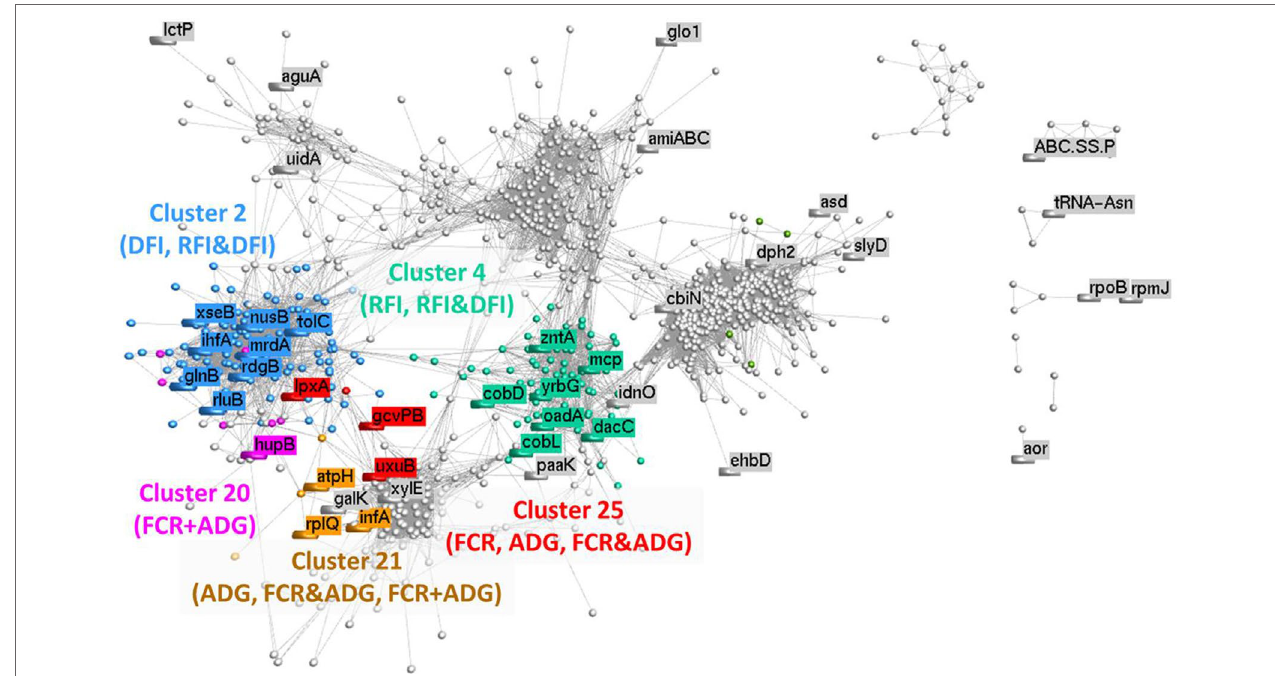
FIGURE 5 | Correlation network analysis of metagenomic data: Each node represents a vector of relative abundances of each microbial gene in all 42 animals, and the edges represent a correlation between the microbial genes. A minimum correlation threshold of 0.80 was applied to the network. Different colors illustrate different clusters, which were calculated using MCL method (inflation: 2; preinflation: 2; scheme: 6). Clusters identified by numbers were found to be significantly ( P < 0.05) enriched for microbial genes identified for the traits whose abbreviations are between brackets (FCR, feed conversion ratio; ADG, average daily gain; RFI, residual